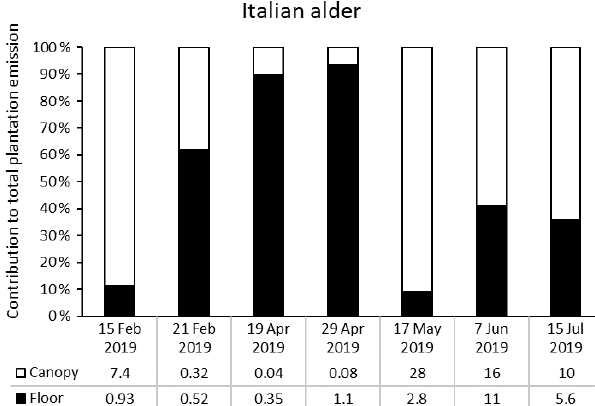
Figure 5. Percentage contribution of canopy (white bar) and forest floor (black bar) emissions to the total monoterpene emissions from SRF plantations at East Grange, Fife, Scotland. Numbers below the bars are the total monoterpene emissions in µgCm − 2 h − 1